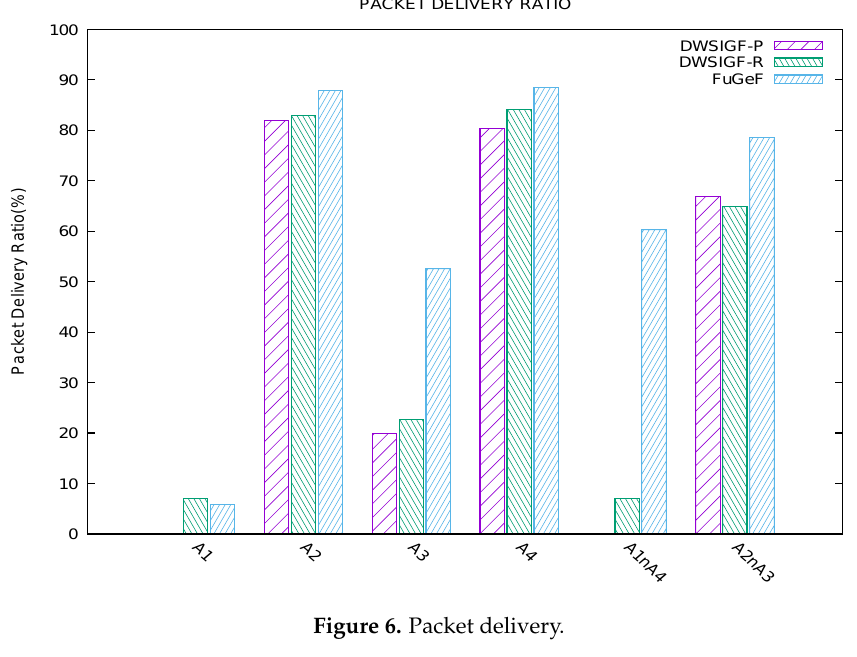
Figure 6. Packet